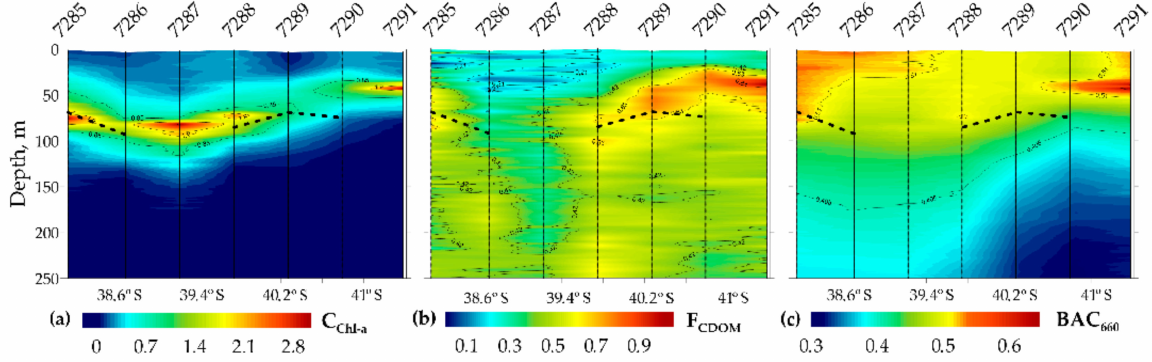
Figure 11. Section of chlorophyll “a” concentration (C chl-a , µ g/L) ( a ), fluorescence intensity of colored dissolved organic matter (FCDOM, QSU) ( b ) and directional light attenuation index (BAC660, FTU) ( c ); Dashed black lines on the sections mark the depth of the photic zone